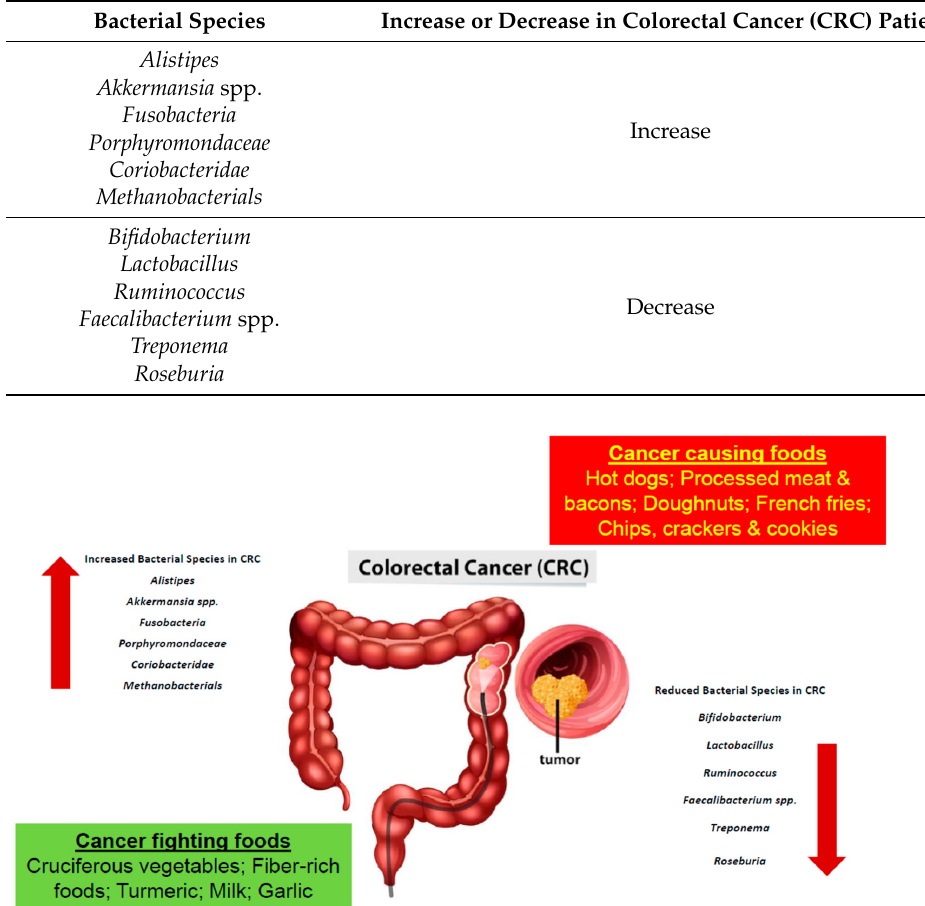
Table 1. Various bacterial species are found to associate positively or negatively with CRC. In patients diagnosed with CRC the bacteria families found to have increased in number include Alistipes , Akkermansia spp., Fusobacteria , Porphyromondaceae , Coriobacteridae and Methanobacterials . Whereas the bacteria species belonging to Bifidobacterium , Lactobacillus , Ruminococcus , Faecalibacterium spp., Treponema and Roseburia are decreased in number [27].